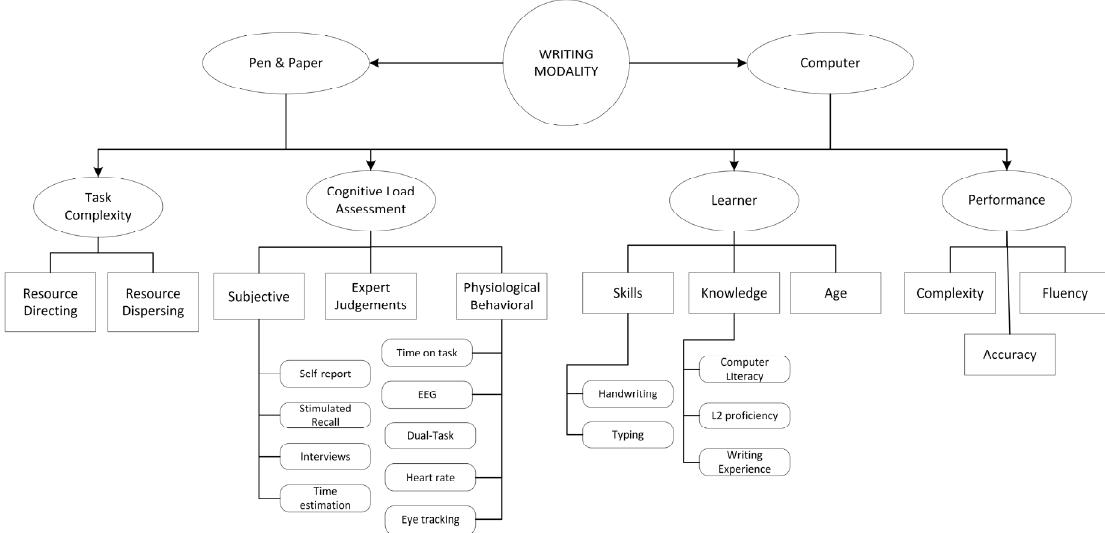
Figure 1. Writing modality as a task complexity